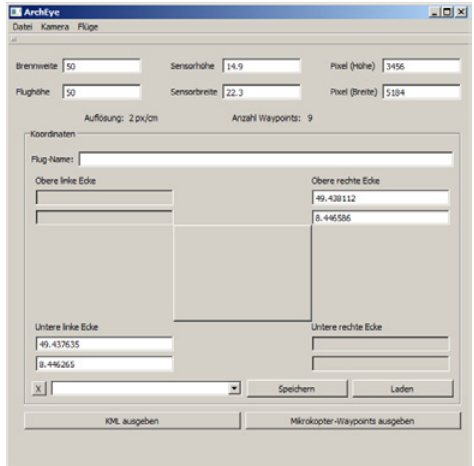
Figure 3: The software.